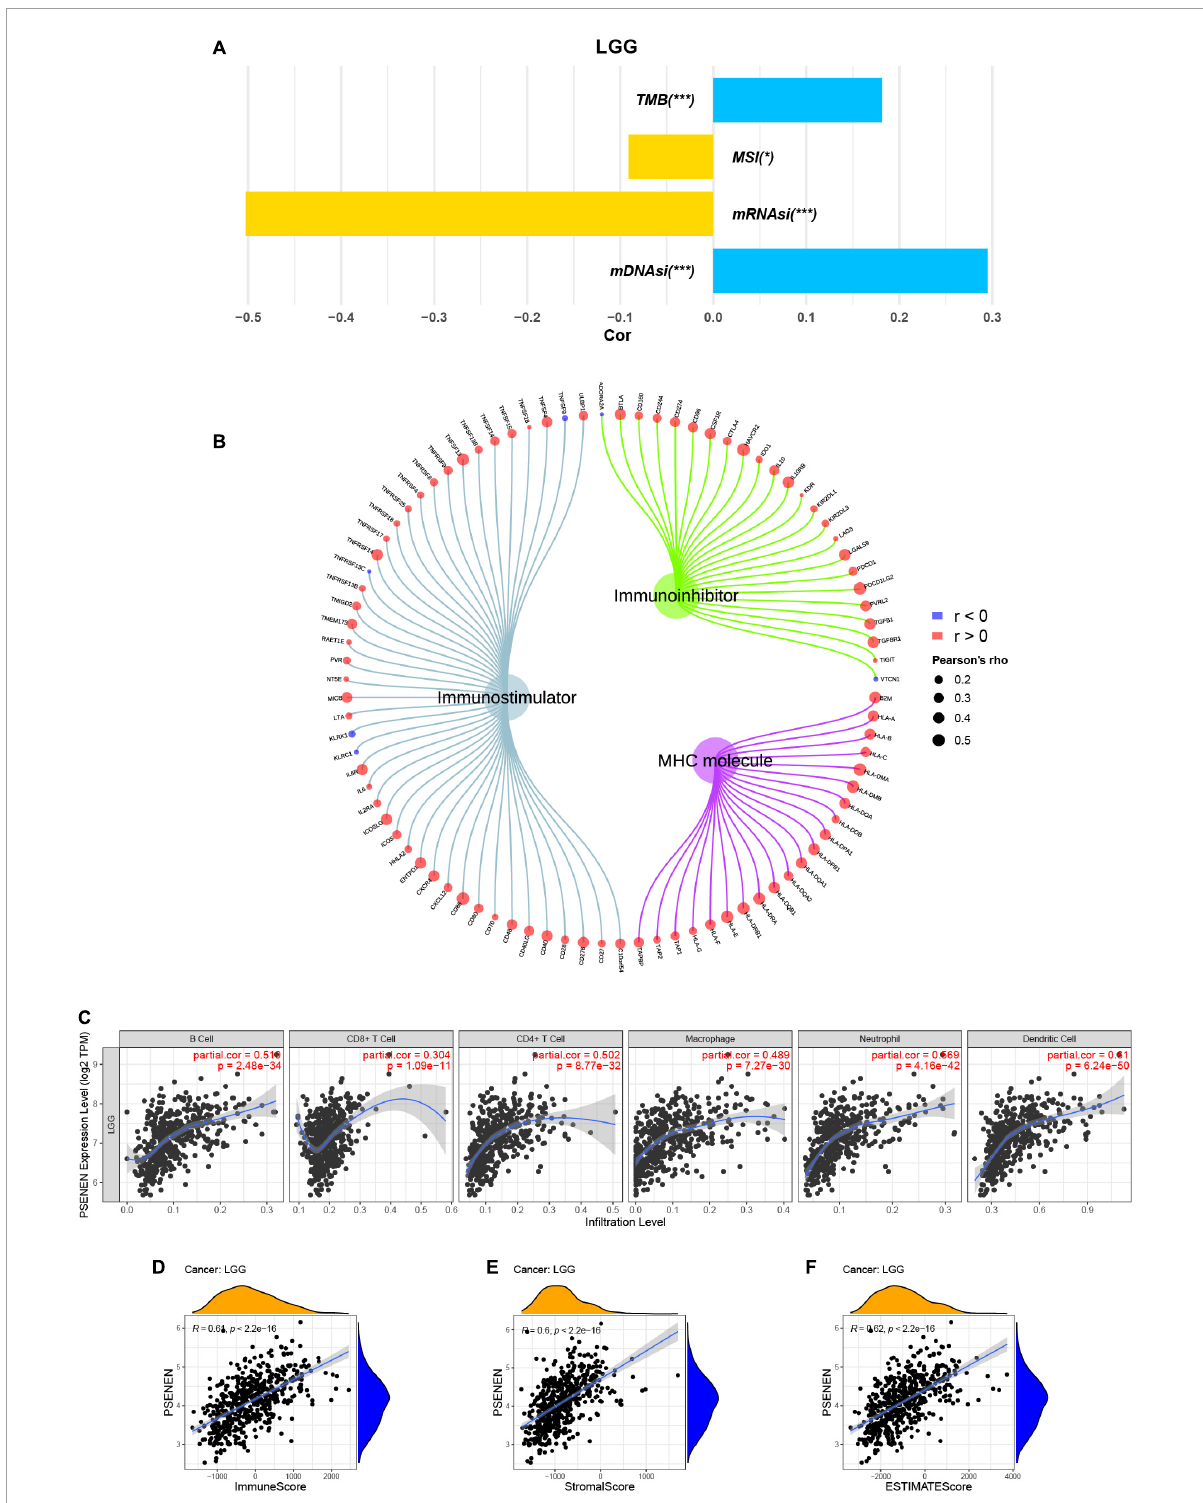
FIGURE5 Correlations between PSENEN expression and multiple immune-related factors in LGG. (A) The relationship between PSENEN expression and TMB, MSI, mRNAsi, and mDNAsi. (B) Correlation of PSENEN expression level with levels of immunostimulator, immuno-inhibitory, and MHC molecule-related genes. (C) Correlation of PSENEN expression with immune cell infiltration levels. Correlation of PSENEN expression with (D) ImmuneScore, (E) StromalScore and (F) ESTIMATEScore in LGG. ‘*’ and ‘***’ indicate p < 0.05 and p < 0.001,